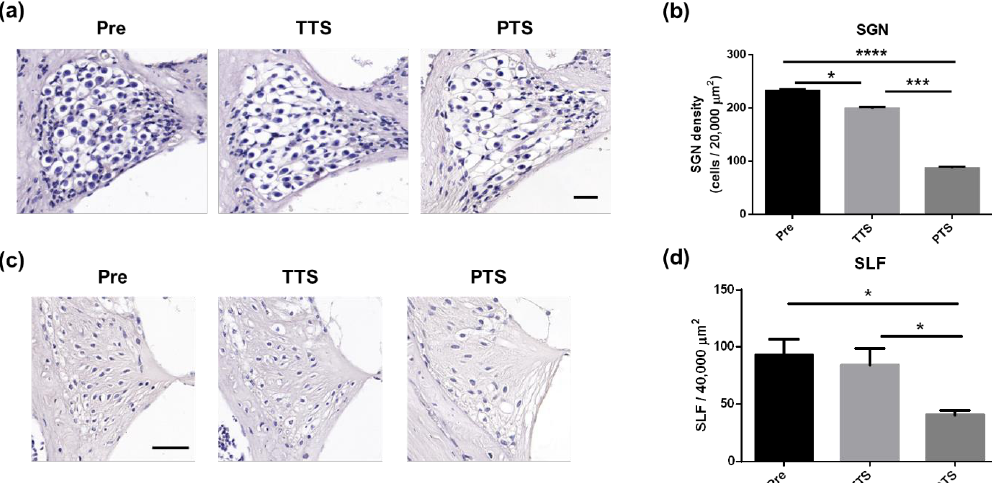
Figure 2. Changes of spiral ganglion neurons (SGNs) and spiral ligament after noise exposure. ( a ) SGNs were observed before (pre) and 14 d after (post) noise exposure. Representative pictures ( a ) and the number of SGNs ( b ) in the basal turn were obtained. ( b ) Both TTS and PTS groups showed a significant reduction in SGNs (hematoxylin positive cells/20,000 μm 2 ) after noise exposure. PTS induced a further decrease in SGN as compared to TTS animals at 14 d post noise trauma. Scale bars represent 20 μm. ( c ) A major cell type in spiral ligament, type IV fibrocytes, were visualized by nucleic acid staining (Hematoxylin) before (normal) and 14 d after noise exposure. ( d ) The number of spiral ligament type IV fibrocytes (SLFs) in the basal turns of cochlea was significantly decreased by PTS at 14 d post noise exposure. Scale bar represents 50 µ m. Graphs represent mean ± S.E.M. n = 4. One-way ANOVA with Tukey’s multiple comparisons test. * p < 0.05, *** p = 0.003, and **** p <